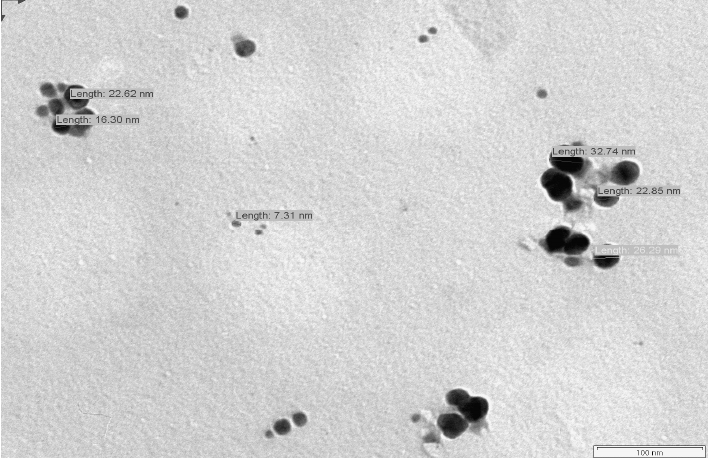
Figure 2. TEM micrograph at 100,000 times magnification recorded from a drop-coated film of an aqueous solution incubated with Bacillus subtilis culture supernatant and reacted with 1 mM Ag + ions for 120 h at 40 o C. The scale bar corresponds to 100